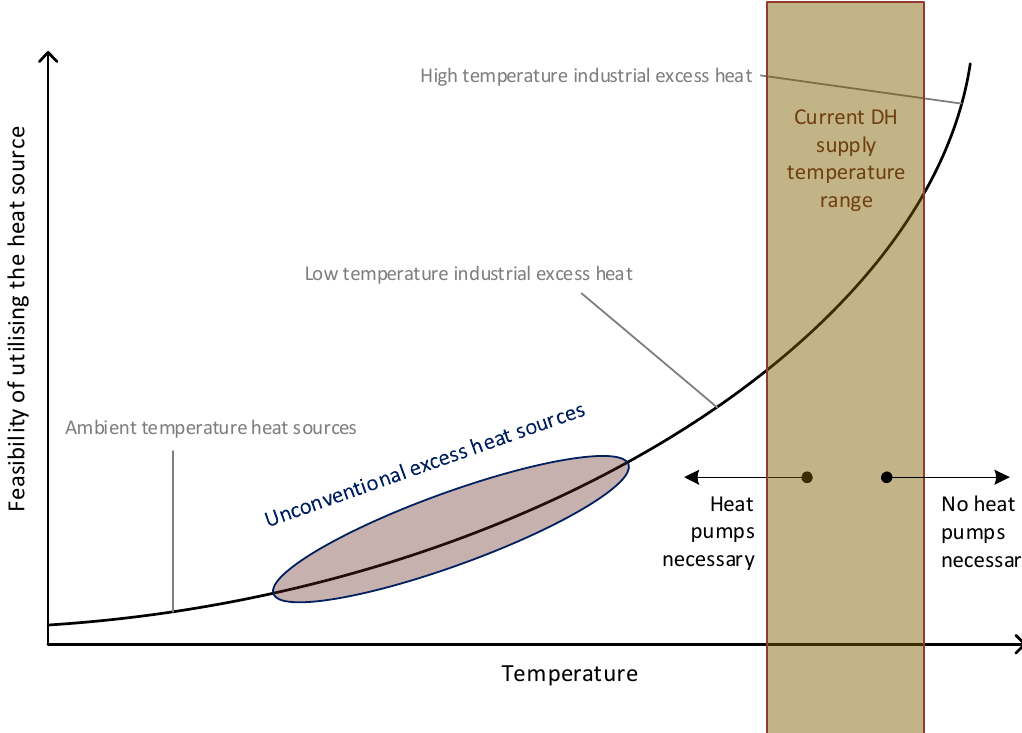
Figure 1. Principal diagram illustrating the increasing feasibility of heat sources with increasing temperatures. Heat sources with temperatures above the district heating (DH) supply temperature might be utilized without a heat pump. However, to utilize a heat source with a lower temperature, a heat pump is needed.